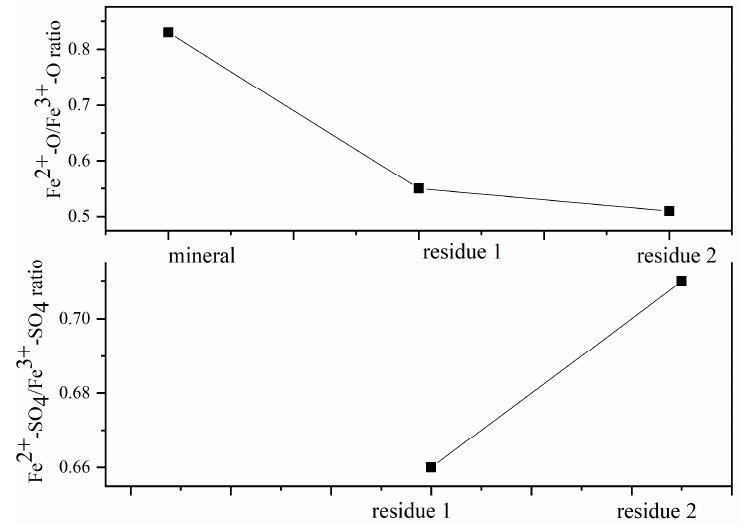
Figure 3. Fe 2+ -O/Fe 3+ -O ratio and Fe 2+ -SO 4 /Fe 3+ -SO 4 ratio on residues surface.